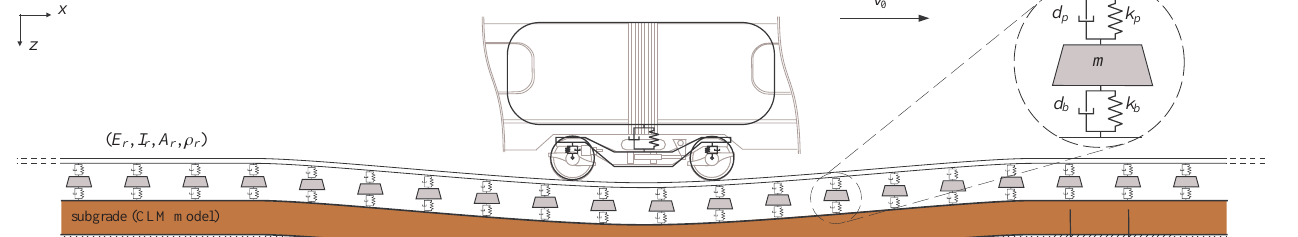
Figure 7. The vehicle / track / foundation